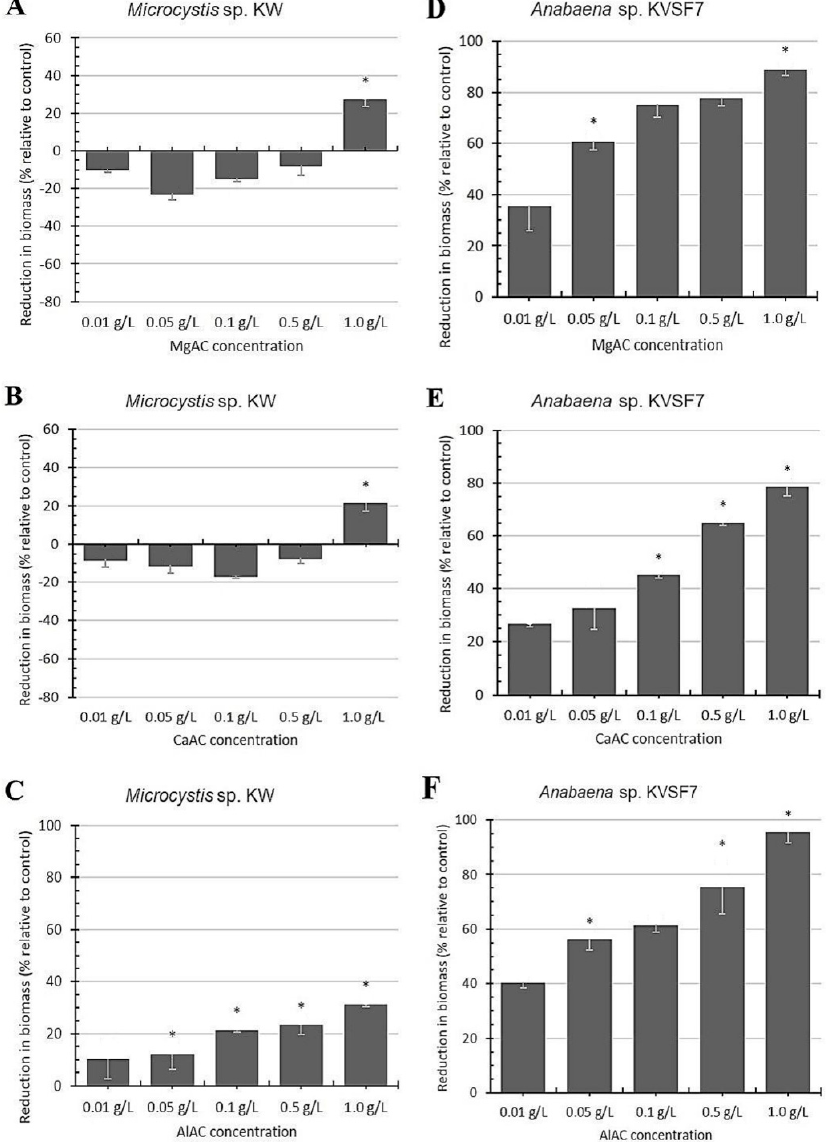
Figure 2. Reduction in biomass of M.S. culture ( A – C ) and A.S. culture ( D – F ) in co-cultures according to type and concentration of ACs. The standard deviations of the mean ( n = 3) are represented by the error bars. A p < 0.05 value is considered to represent significant difference. The “*” sign is applied for this significant